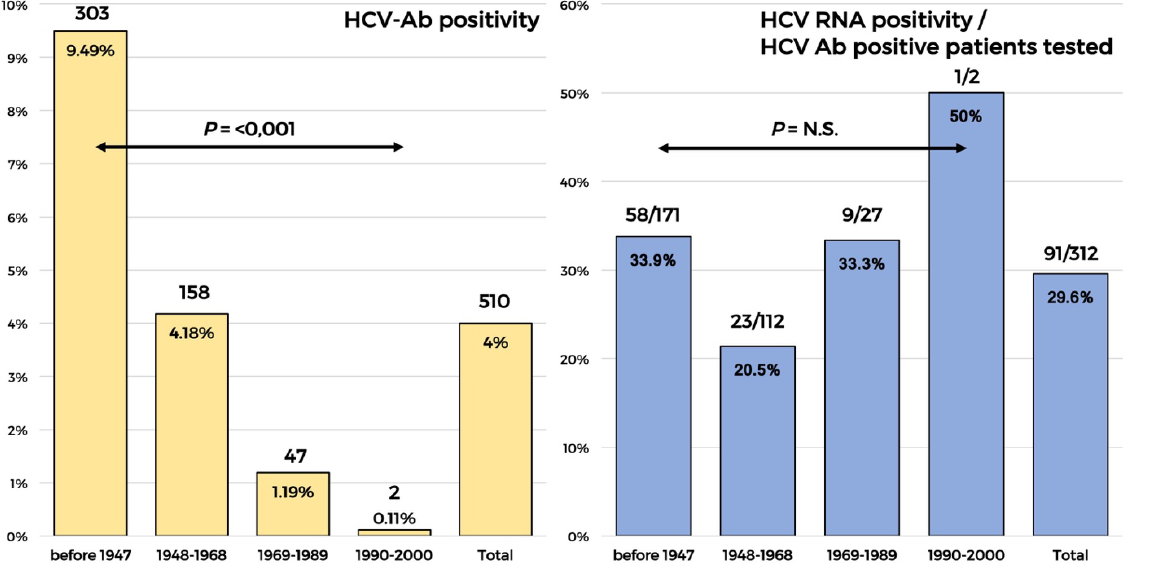
Figure 2. HCV-Ab prevalence and the proportion of active infection detected by birth cohort.